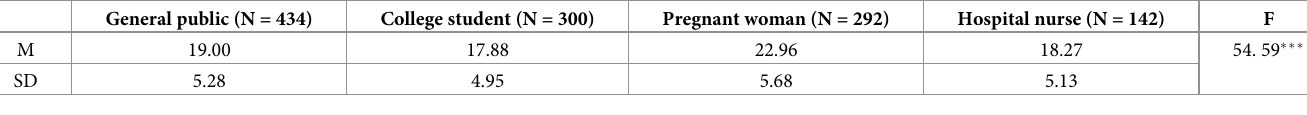
Table 2. Comparing the fear of infection by